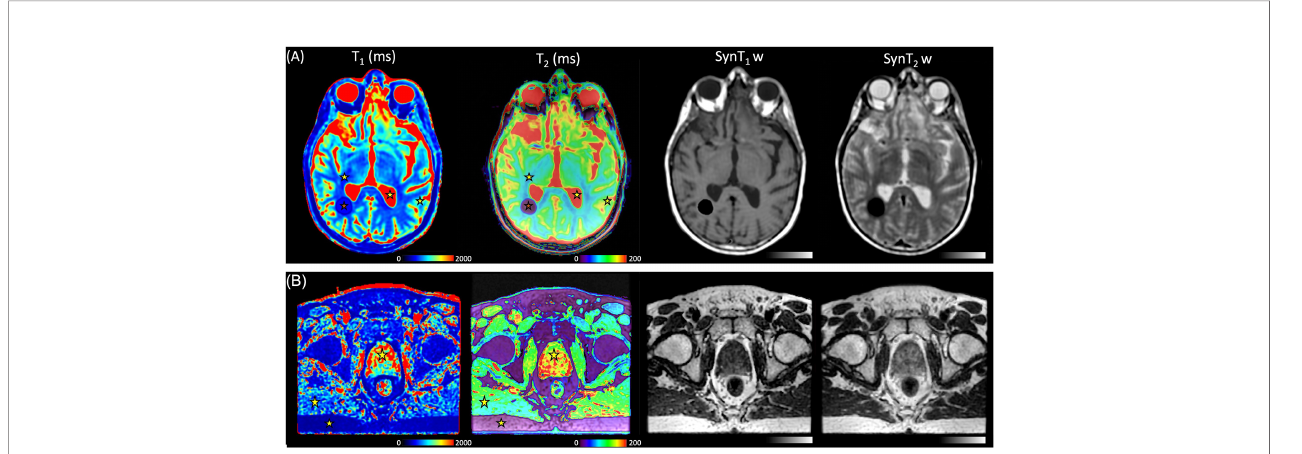
FIGURE 7 | (A) T 1 maps, T 2 maps, SynT 1 w, and SynT 2 w of the brain in a 39-year-old man with known calci fi ed lesion. Stars represent the volume of interest (VOI) of the mean measured values, white matter (WM), gray matter (GM), and cerebrospinal fl uid (CSF), for the MAGiC ® method. (B) T 1 maps, T 2 maps, SynT 1 w, and SynT 2 w of the pelvis in a 72-year-old man with prostate cancer. Stars represent the VOI of the mean measured fat, muscle, and prostate for the MAGiC ® method and conventional sequences.